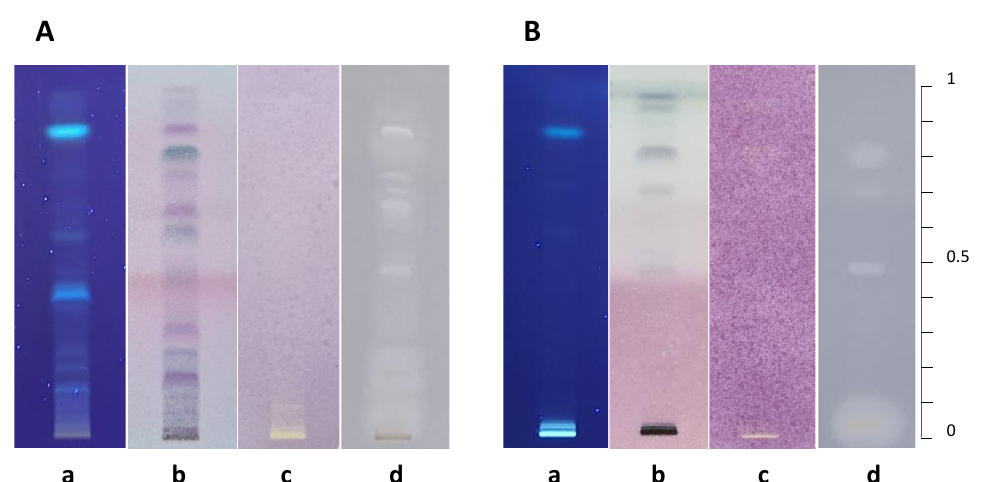
Figure 3. TLC plates of ( A ) Fomitopsis pinicola and ( B ) Hypholoma fasciculare EtOAc extracts (50 µg). Detection ( a ) under UV at 366 nm, ( b ) with vanillin-sulfuric acid reagent, ( c ) with DPPH, ( d ) with COX-2/arachidonic acid/TMPD.